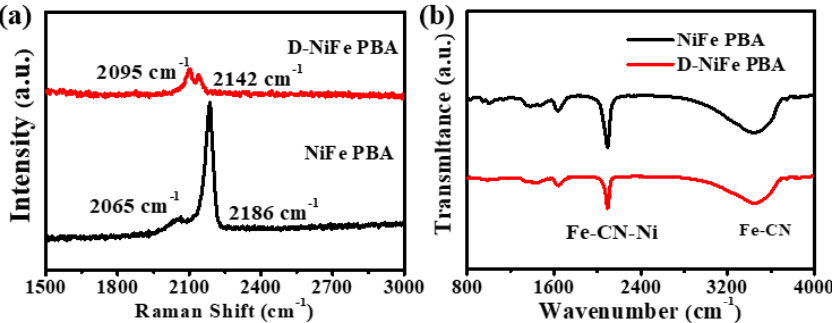
Figure 3. ( a ) FT-IR spectra ( b ) Ramam spectra of NiFe PBA and D-NiFe PBA.